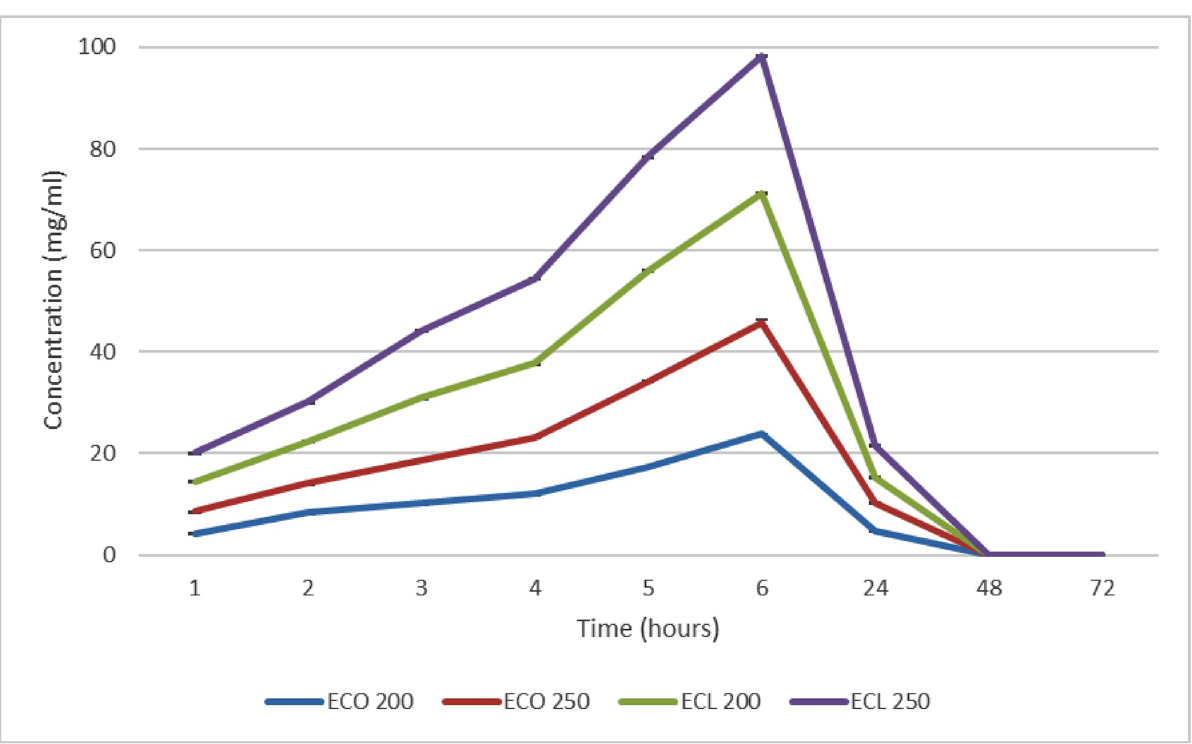
Fig 5. Concentration of EOs release from tissue conditioner discs (ECO 200, ECO 250, ECL 200, ECL 250) over 1 h, 2 h, 3 h, 4 h, 5 h, 6 h, 24 h, 48 h, and 72 h. Values were expressed as means and standard deviation. The maximum release was observed at 6 h, the release pattern was reduced. Highest EO release was observed by ECL 250, followed by ECL 200, ECO 250 and least was for ECO 200.